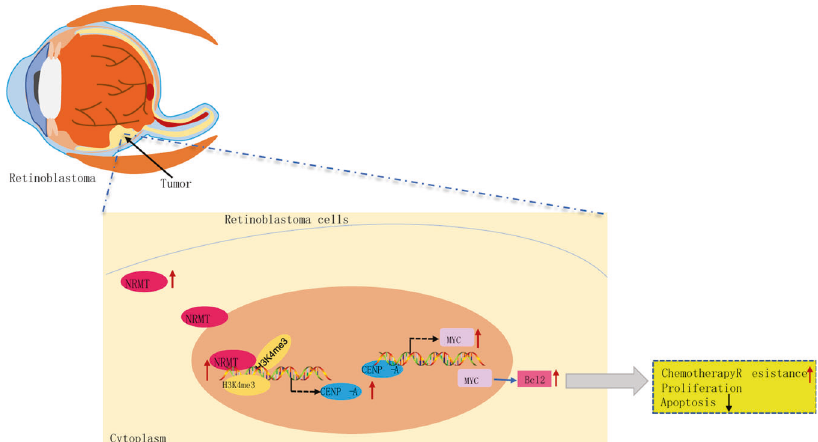
Fig. 7 Schematic diagram illustrating the action of NRMT on chemosensitivity of retinoblastoma cells via the CENPA-mediated Myc/Bcl2 axis. NRMT upregulates CENPA through histone methylation to promote the enrichment of CENPA on the Myc promoter region, by which Bcl2 expression is elevated so that chemosensitivity of retinoblastoma cells is